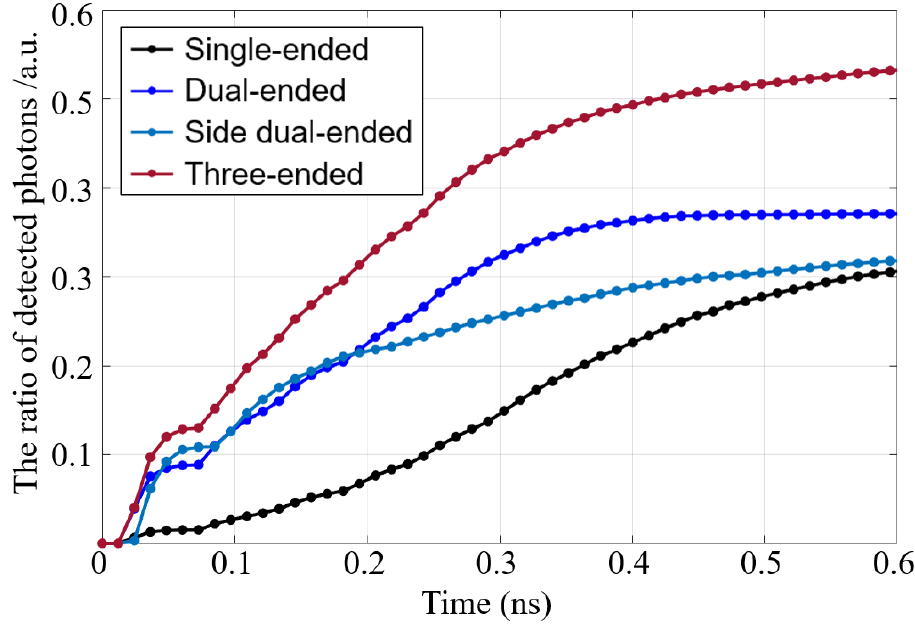
Figure 6. CDF of the light output of the simulation.